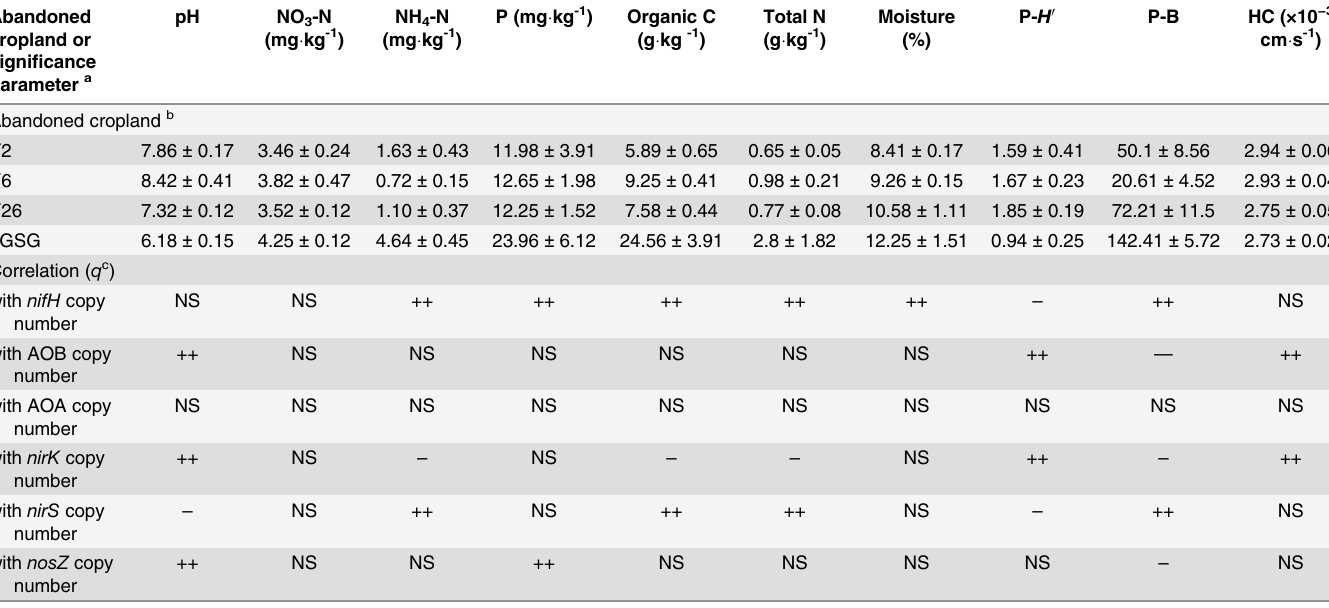
a All environmental variables are shown and include pH, NO 3 -N, NH 4 -N, available phosphorus (P), organic carbon (organic C), total nitrogen (total N), soil moisture, plant diversity (P- H 0 ), plant biomass (P-B), and hydraulic conductivity (HC). b Y2, Y6, and Y26 indicate the number of years that the fi elds were abandoned (2, 6, and 26 years, respectively). LGSG, light-grazing steppe grassland. The values shown for management factors represent the mean ± standard error.